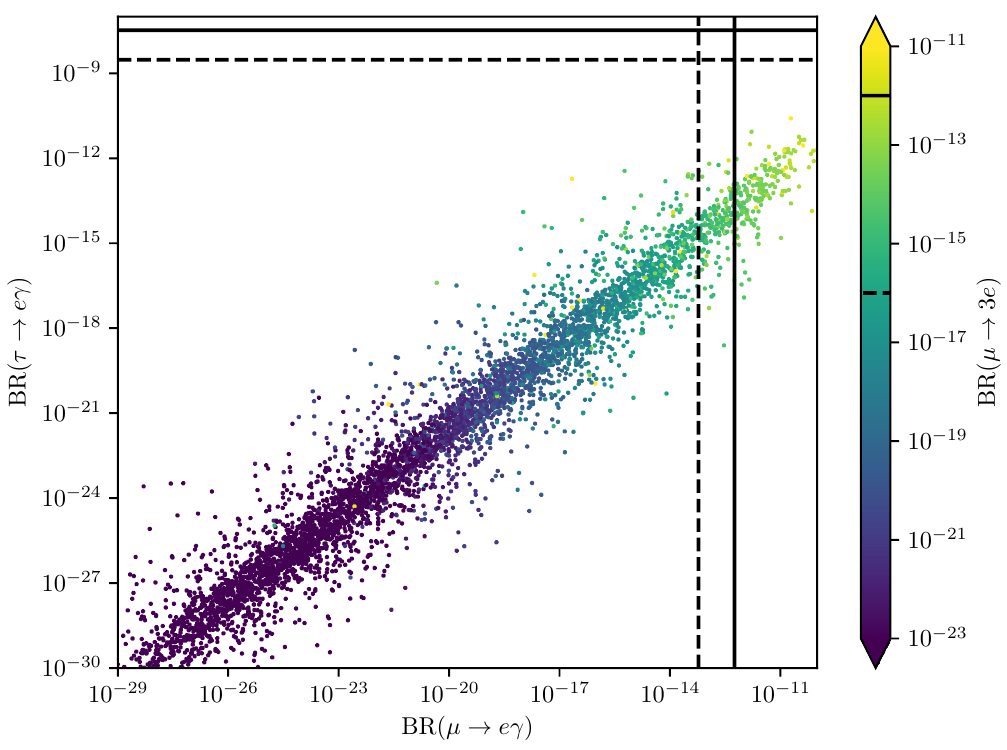
Figure 9 . Correlations of the branching ratios for the LFV processes (cid:22) for viable models with singlet-doublet fermion DM. Also shown are current (full lines) and future (dashed lines) exclusion limits [41, 42,